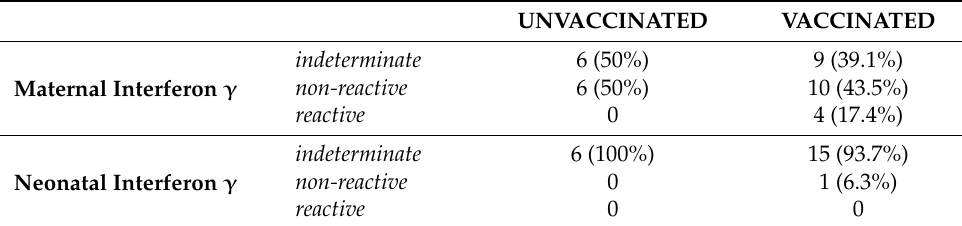
Table 5. Maternal and neonatal plasma interferon γ (INF γ ) in vaccinated vs. unvaccinated pregnant